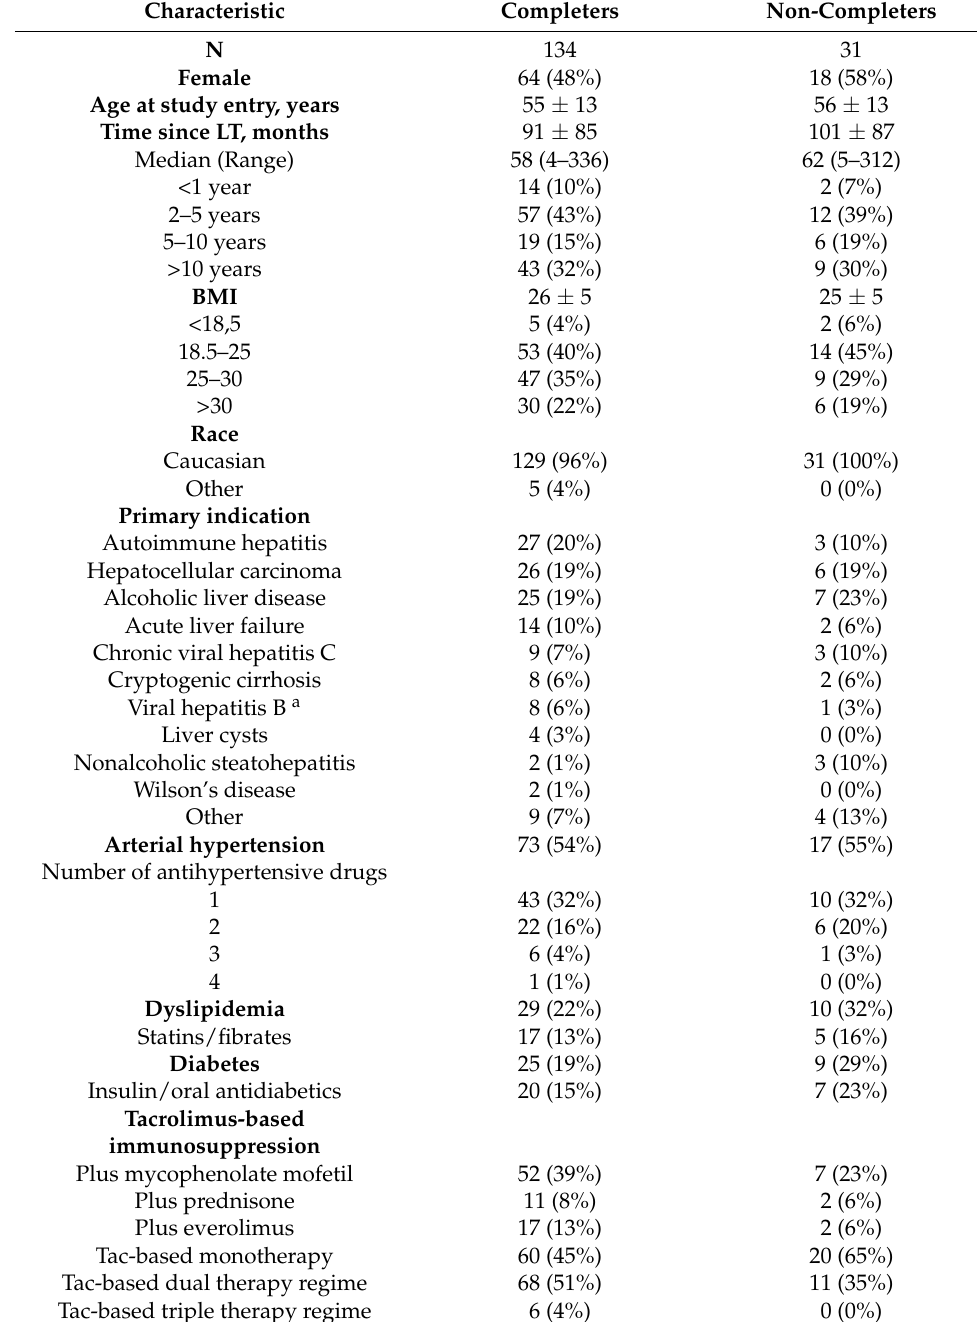
Table 1. Descriptive characteristics of the study group at baseline, means ± SD, median (range) or N (%).